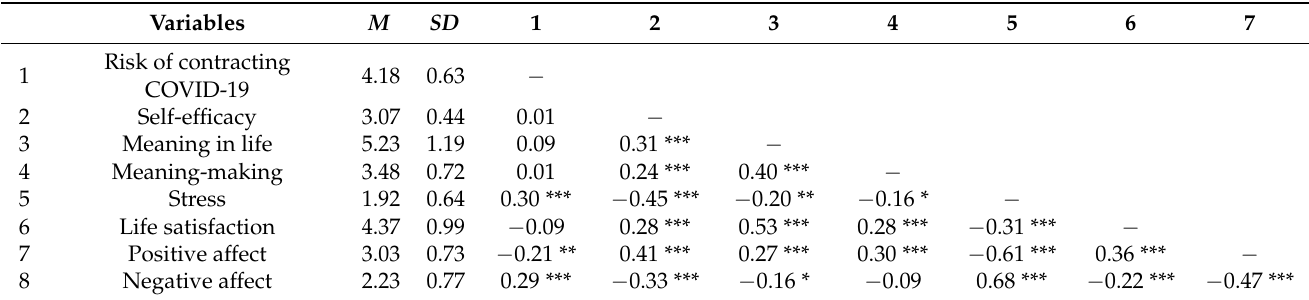
Table 1. Means, standard deviations and correlations between risk of contracting COVID-19, self-efficacy, meaning in life, meaning-making, stress and the dimensions of subjective